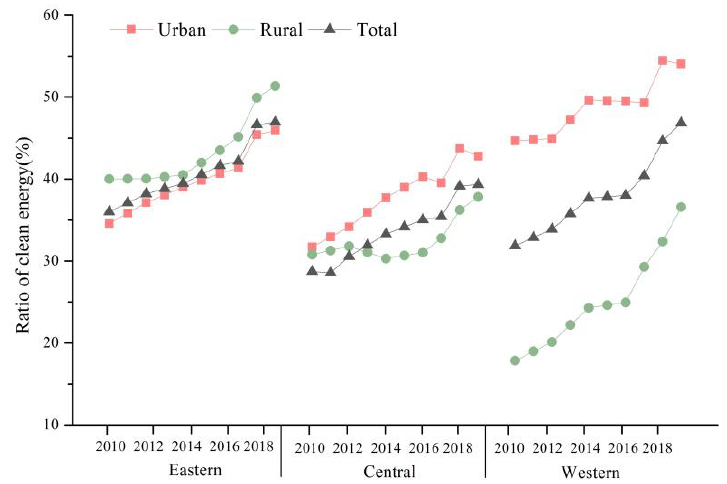
Figure 8. Changes in the energy structure of urban and rural residents in the three different regions of China during 2010 – 2019.